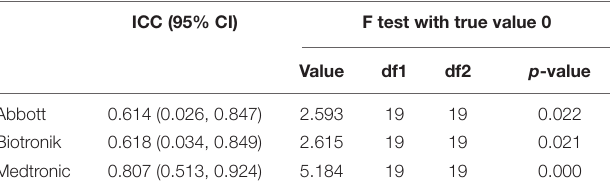
TABLE 4 | Intraclass correlation coefficient between average daily physical activity measured by the Actigraph GT3X+ and cardiovascular implantable electronic devices (hours per